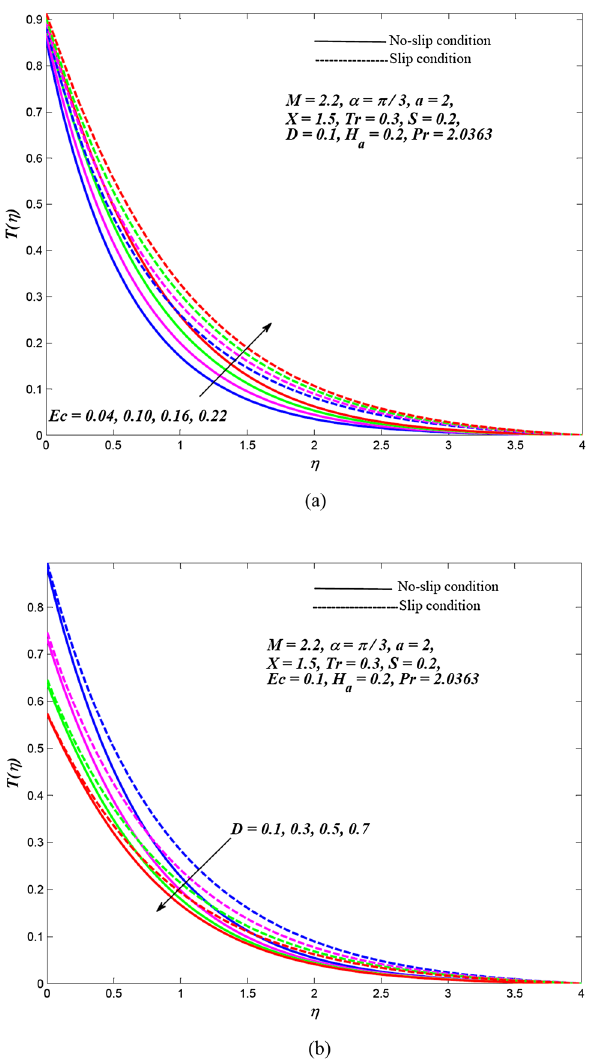
Figure 7. Hybrid temperature dispersal profiles T (η) for varying ( a ) Ec and ( b ) D